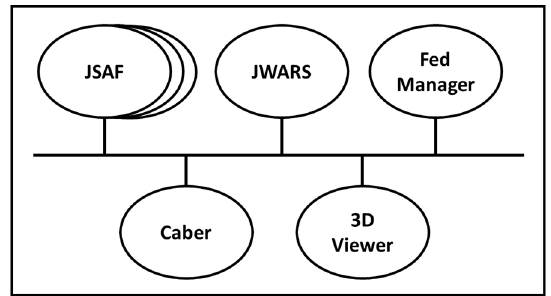
Figure 17. Federation diagram (adapted from [47]).